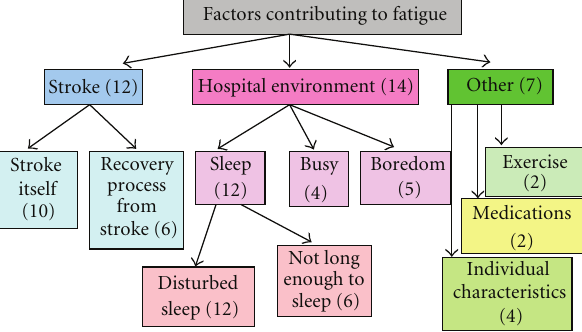
Figure 2: Factors contributing to and exacerbating fatigue.